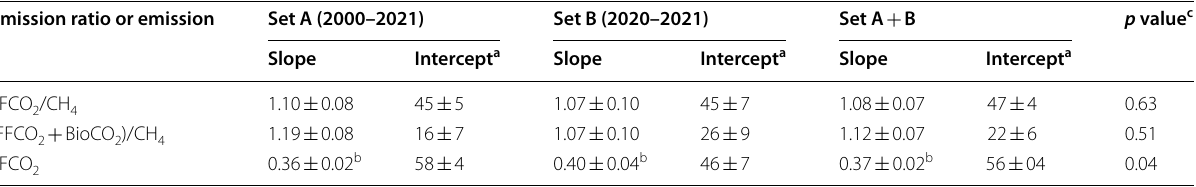
a Units of intercepts are given in mol mol − 1 b Units of slopes for FFCO 1 )/TgC 2 emission are given in (mol mol − c p values are for the hypothesis that there is no significant difference between the slopes for the time-dependent fluxes and modified fluxes